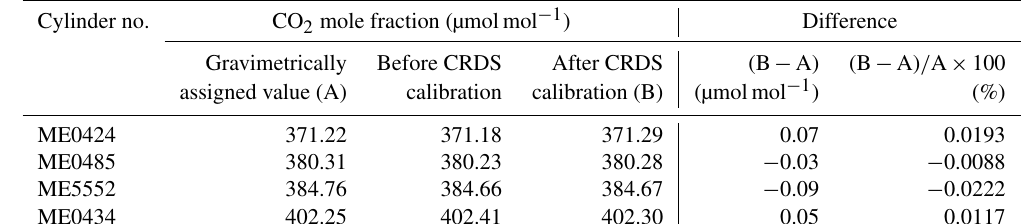
Table 3. Summary of CRDS calibration results.